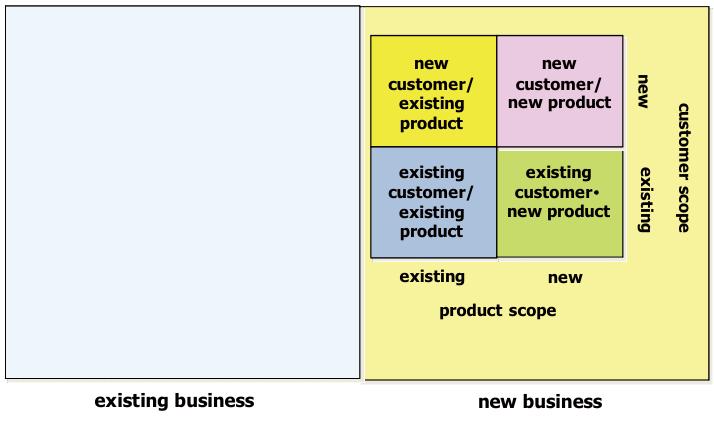
Figure 1. Business